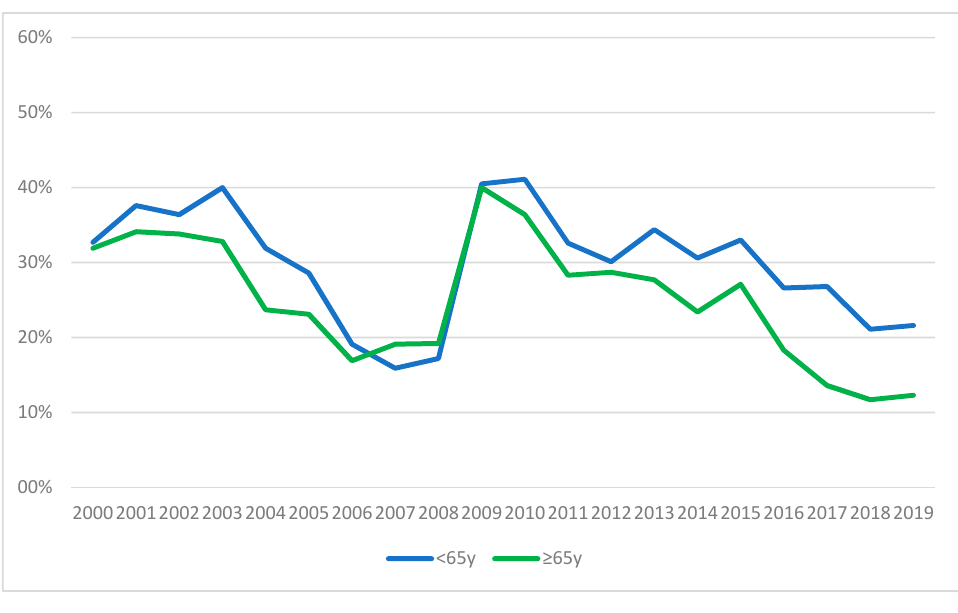
Figure 7. Percentage of urgent requests over time. Figure 6. Percentage of urgent requests over